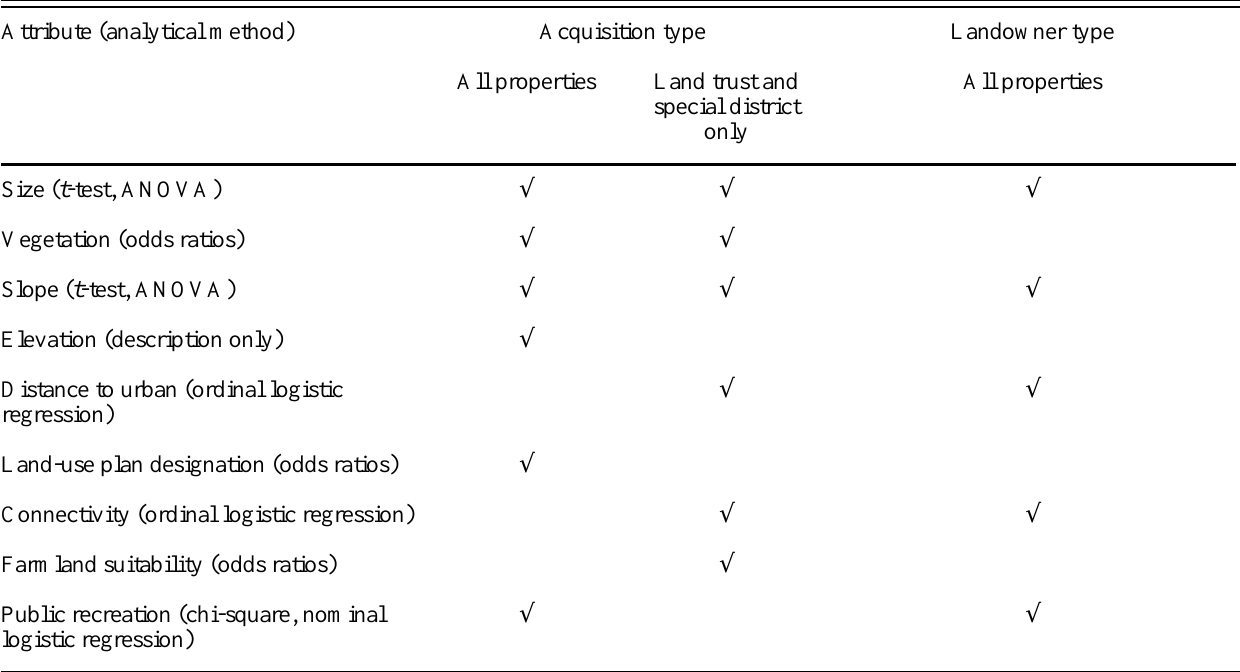
Table 1 . Comparative analyses by acquisition type (fee simple vs. conservation easement) and landowner